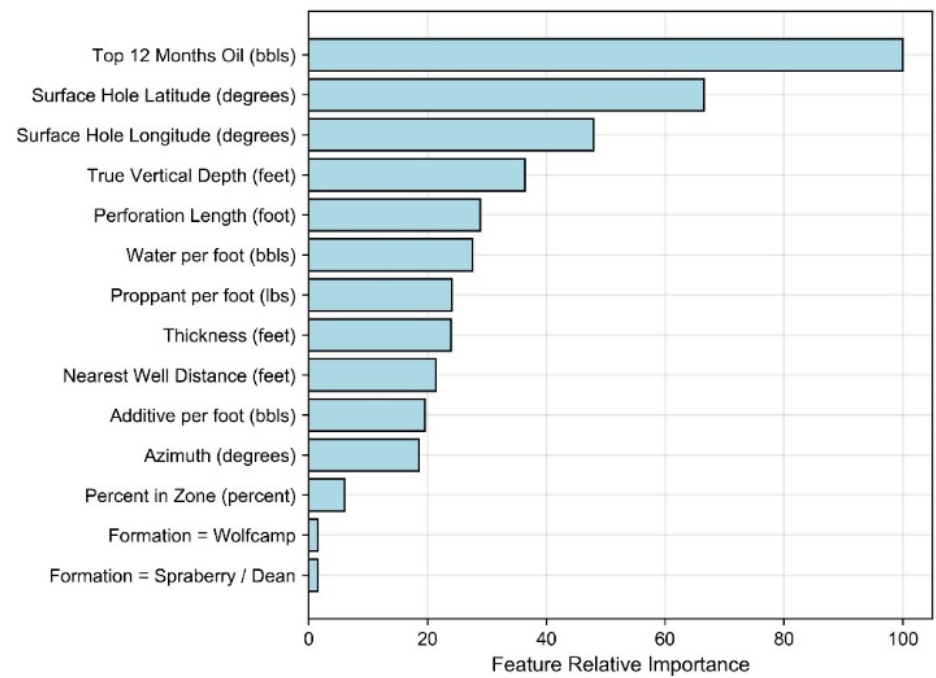
Figure A2. Summary of feature importance for the RF estimator used as part of RFECV.